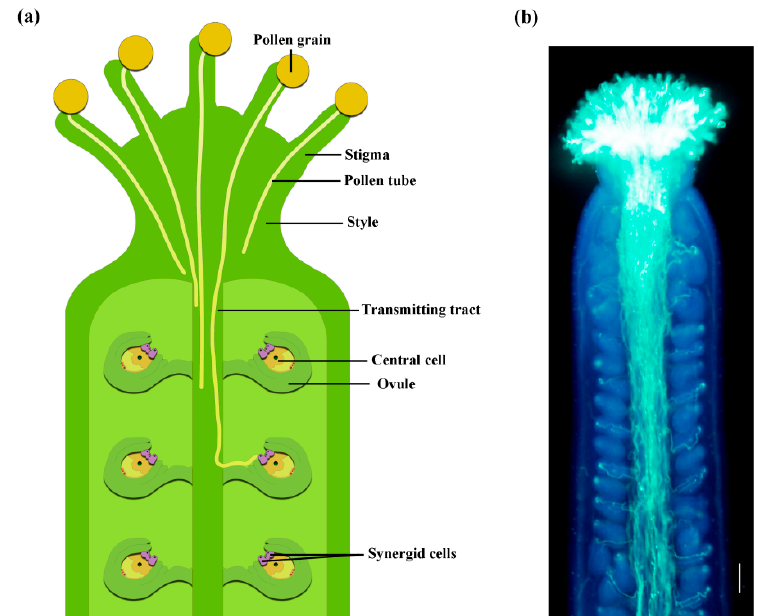
Figure 1. Pollen tube growth in the pistil. ( a ) Schematic diagram of pollen grains that land on the stigma and germinate to produce pollen tubes that grow within the pistil. ( b ) Arabidopsis thaliana pollen tubes in a pistil, stained by aniline blue. The image was observed under Olympus BX63 automatic fluorescence microscope. Scale bar = 100 μ m.